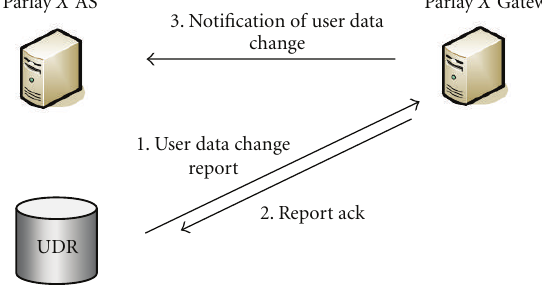
Figure 6: Notifications upon changes of user data.